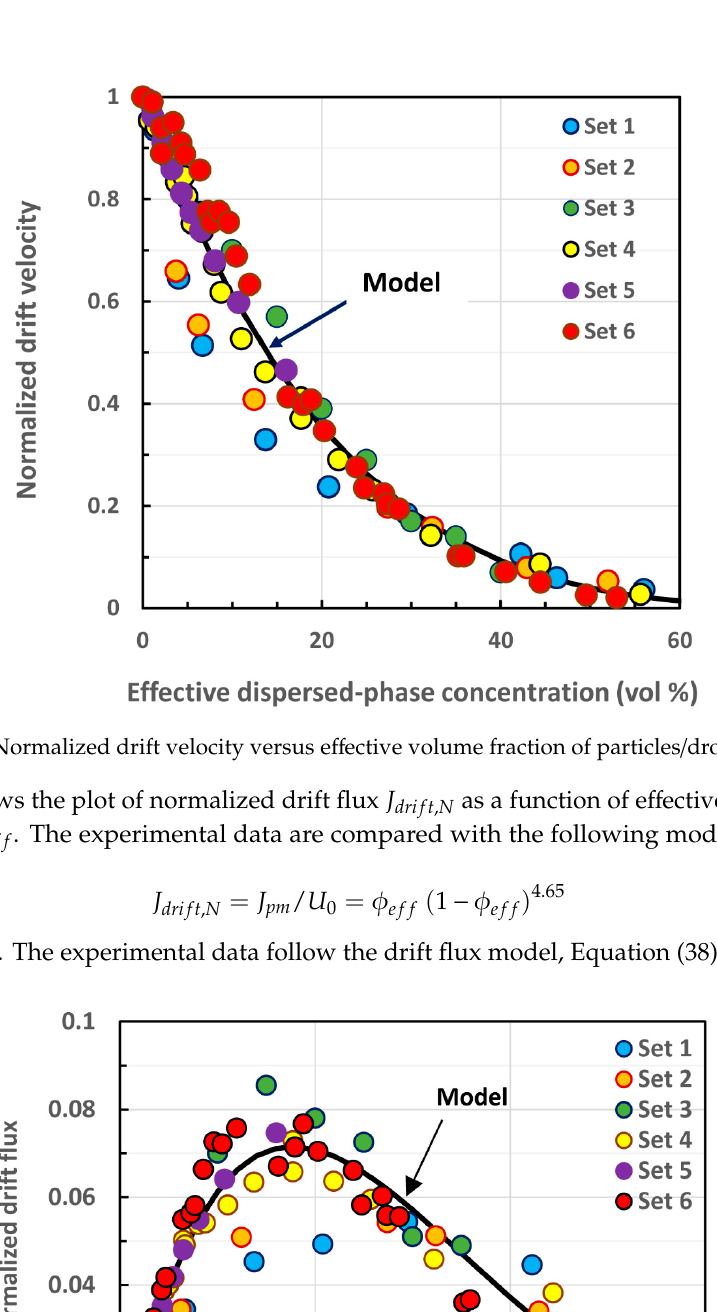
Figure 8. Normalized drift flux J drift , N as a function of e ff ective dispersed-phase concentration φ ef f (vol %).